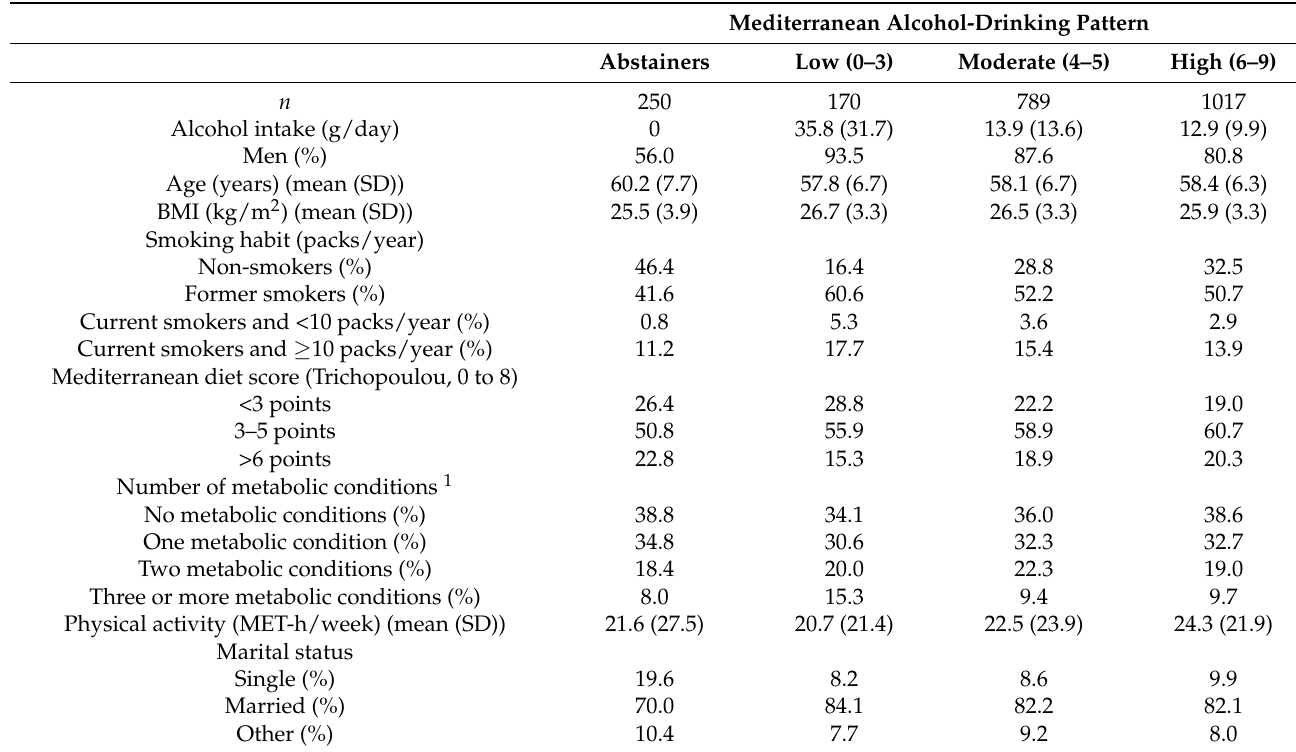
Table 1. Baseline characteristics of participants.